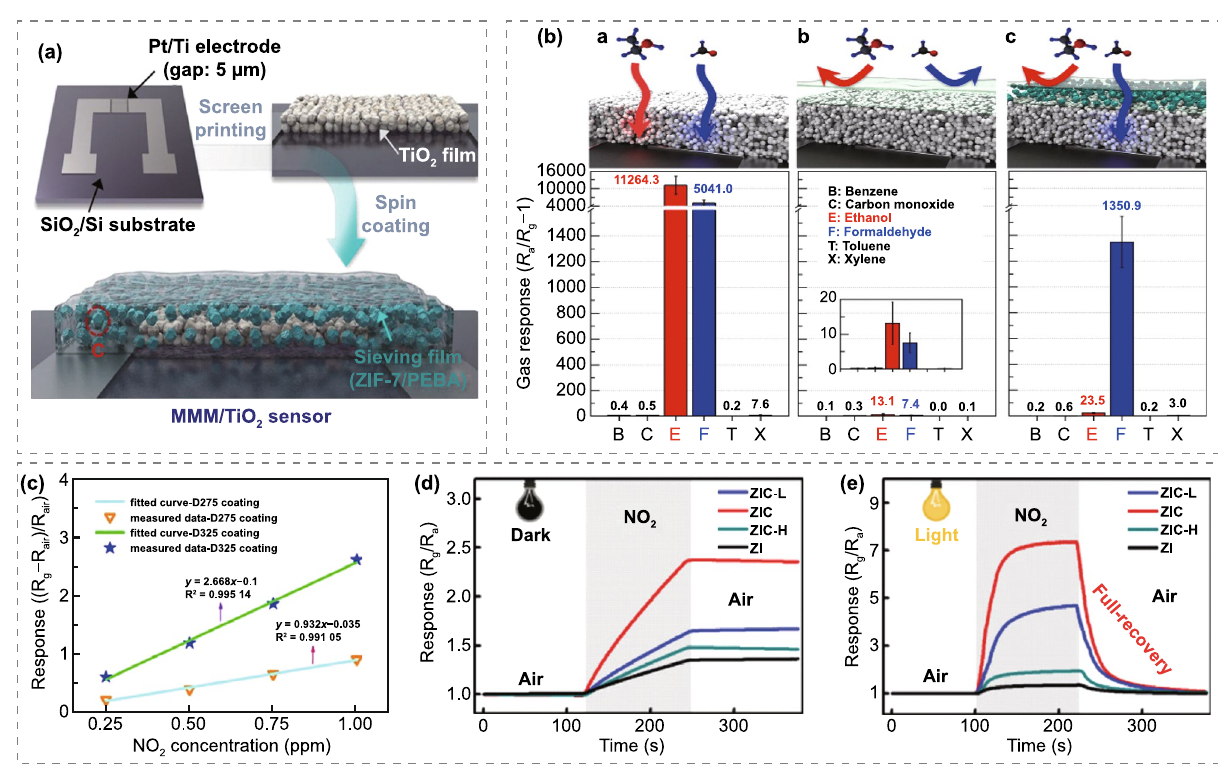
Fig. 10 a The process flow for preparation of ZIF‑7/PEBA coated TiO 2 sensors. b Gas responses of bare TiO 2a , pure PEBA/TiO 2b , and 5MMM/ TiO 2c sensors exposed to different gas with concentration of 5 ppm at RT under UV‑illumination. Reproduced with permission from Ref. [105]. Copyright (2021) Springer Nature. c The linear responses of ZnO 1−x based sensors to 0.25‑1 ppm NO 2 under white‑light illumination. Repro‑ duced with permission from Ref. [70]. Copyright (2017) Elsevier. Transient response of ZI, ZIC, ZIC‑L (lower g‑C 3 N 4 content), ZIC‑H (higher g‑C 3 N 4 content) sensors to 1 ppm NO 2 at RT d in dark, e under visible‑light illumination. Reproduced with permission from Ref. [66]. Copy‑ right (2021)